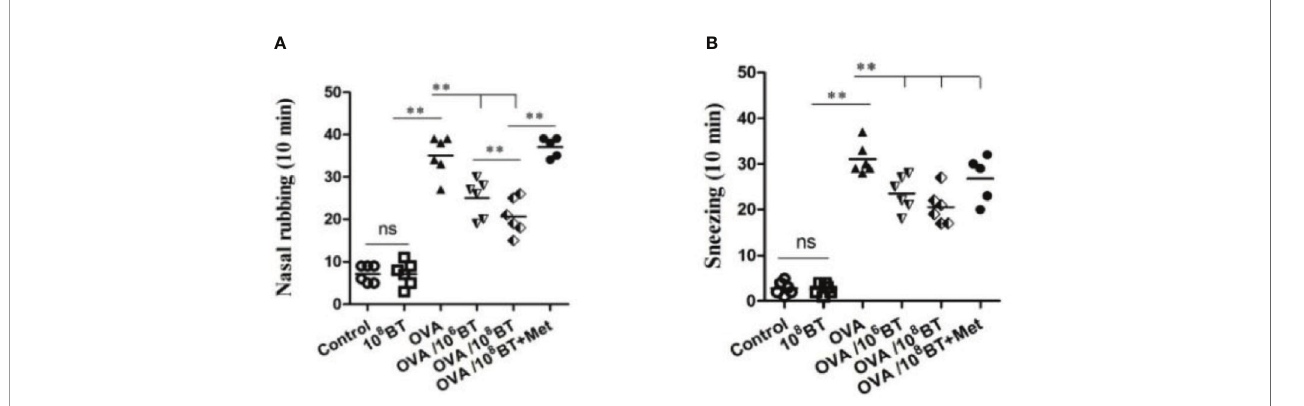
FIGURE 4 | The changes of allergic symptoms. OVA induced an obvious AHR in mice with increased frequency of nasal rubbing (A) and sneezing (B) . The occurrences of nasal rubbing and sneezing were noticeably reduced in OVA/BT group, while OVA/BT+Met inhibited the effect in ameliorating allergic symptoms. ** P